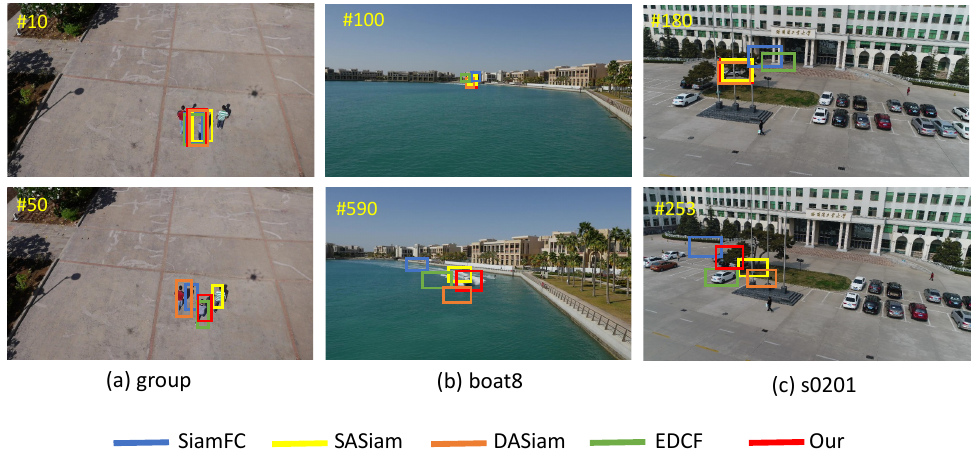
Figure 1. Comparison of the proposed method with the state-of-the-art Siamese network-based trackers (SiamFC [20], SASiam [21], DASiam [22], and EDCF [19]) on the group and boat8 sequences from the UAV123 [6], and s0201 sequence from UAVDT [7]. These methods that have been adopted with